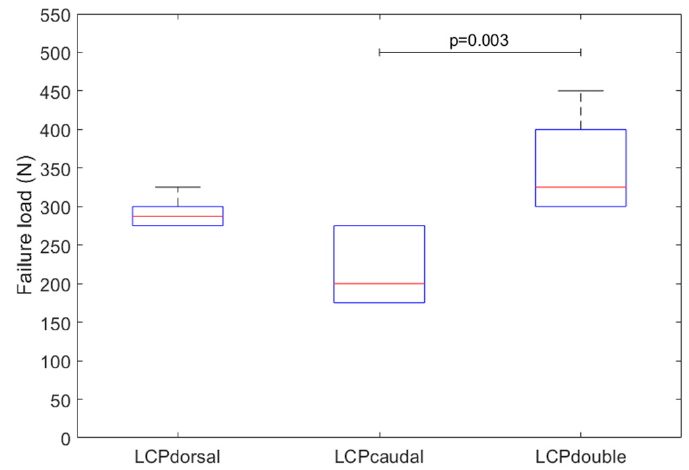
Figure 5. Loads to failure of the three investigated constructs (boxplot shows median (red line), interquartile range (box), and maxima and minima (upper and lower whisker)).